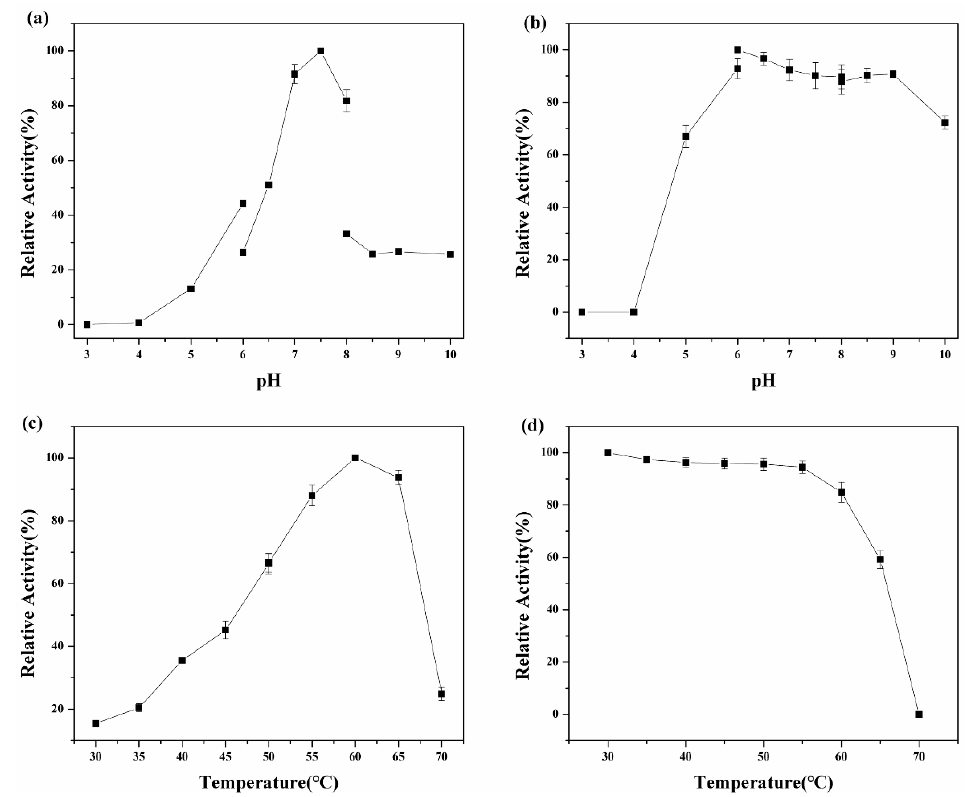
Figure 5. Effects of pH and temperature on enzyme activity and stability. ( a ) Optimal pH, ( b ) pH stability, ( c ) optimal temperature and ( d ) thermal stability of α -galactosidase.